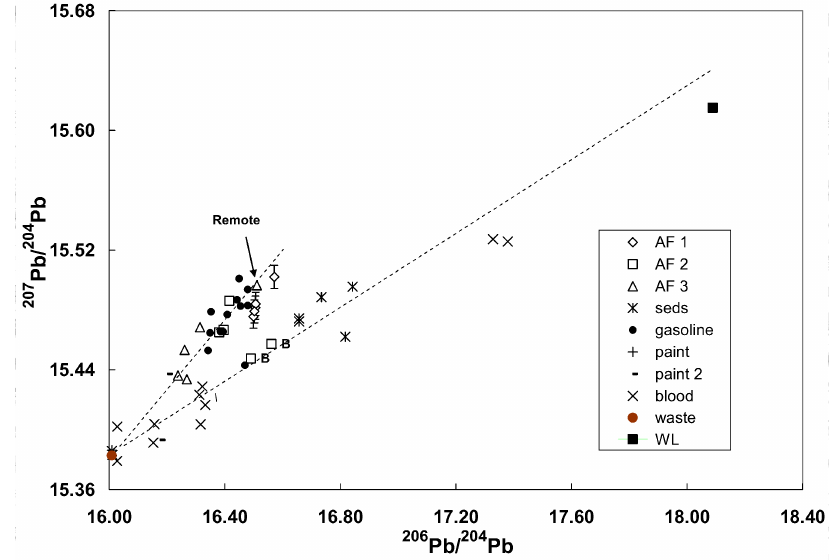
Figure 8. Conventional 204 Pb-based isotope ratio plot for samples from the monitoring program. AF1 to AF3 refer to the 3 air filter sampling periods with AF3 being associated with possible release during abrasive blasting (waste). “B” denotes site B for the second air sampling program. The data for paint 1 and waste are the average values. Error bars are shown for air filter particulates from the first background sampling. The dashed lines are “eye-ball” fit to the data. Seds denote the underwater sediments collected under the bridge; WL are the values for a Pb-Zn mine about 400 million years old about 200 km south west of Sydney. The waste values are identical with the geologically ancient (~1700 million years old) Broken Hill